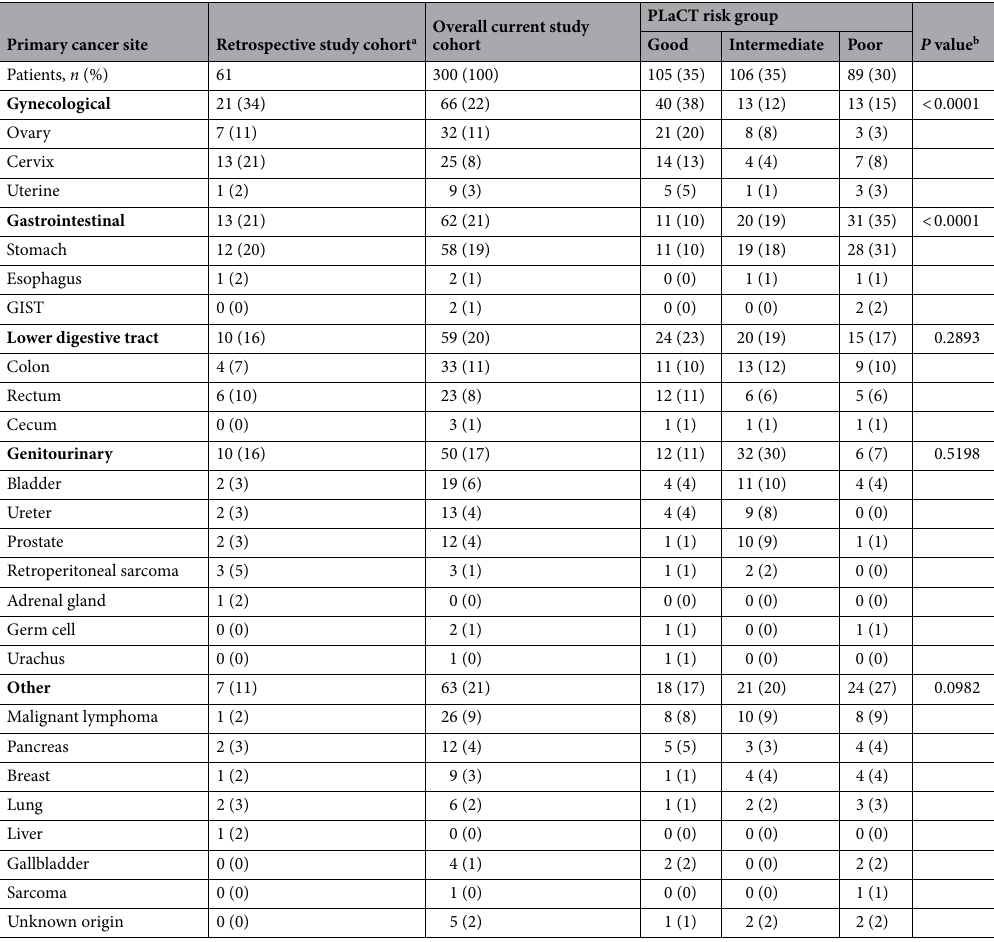
Table 2. Distribution of primary cancer site. GIST gastrointestinal stromal tumor. a Reference 5 . b Comparison among risk groups using chi-squared test for